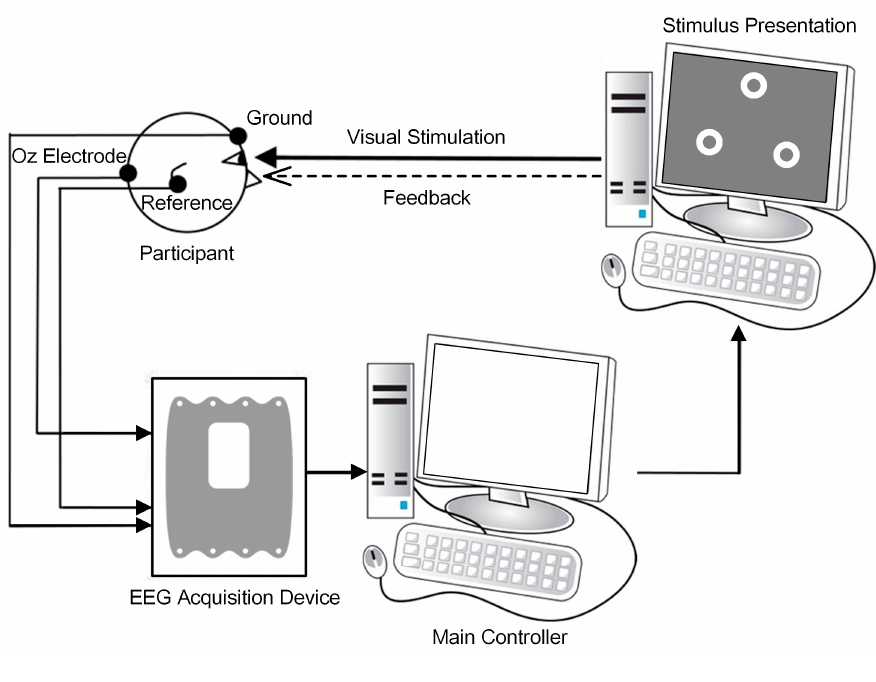
Figure 2. The overall BCI system diagram.